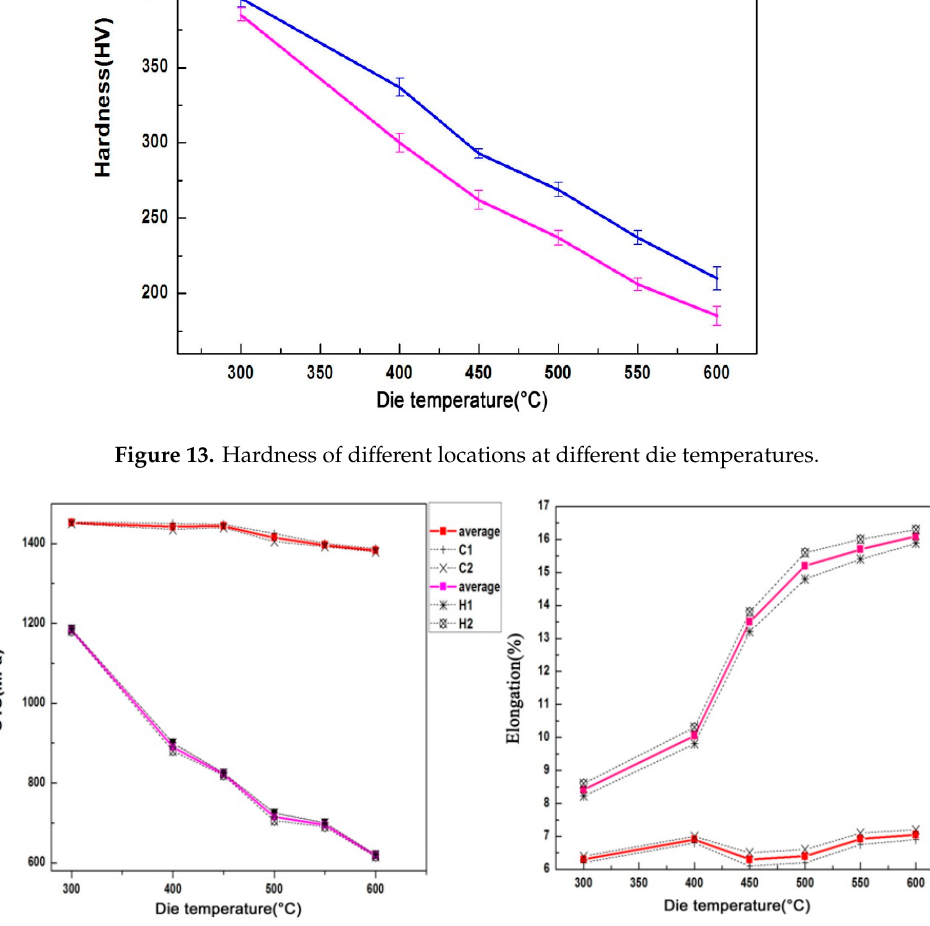
Figure 14. The mechanical properties for two regions at different tool temperatures: ( a ) the average ultimate tensile strength (UTS), and ( b ) the average elongation.